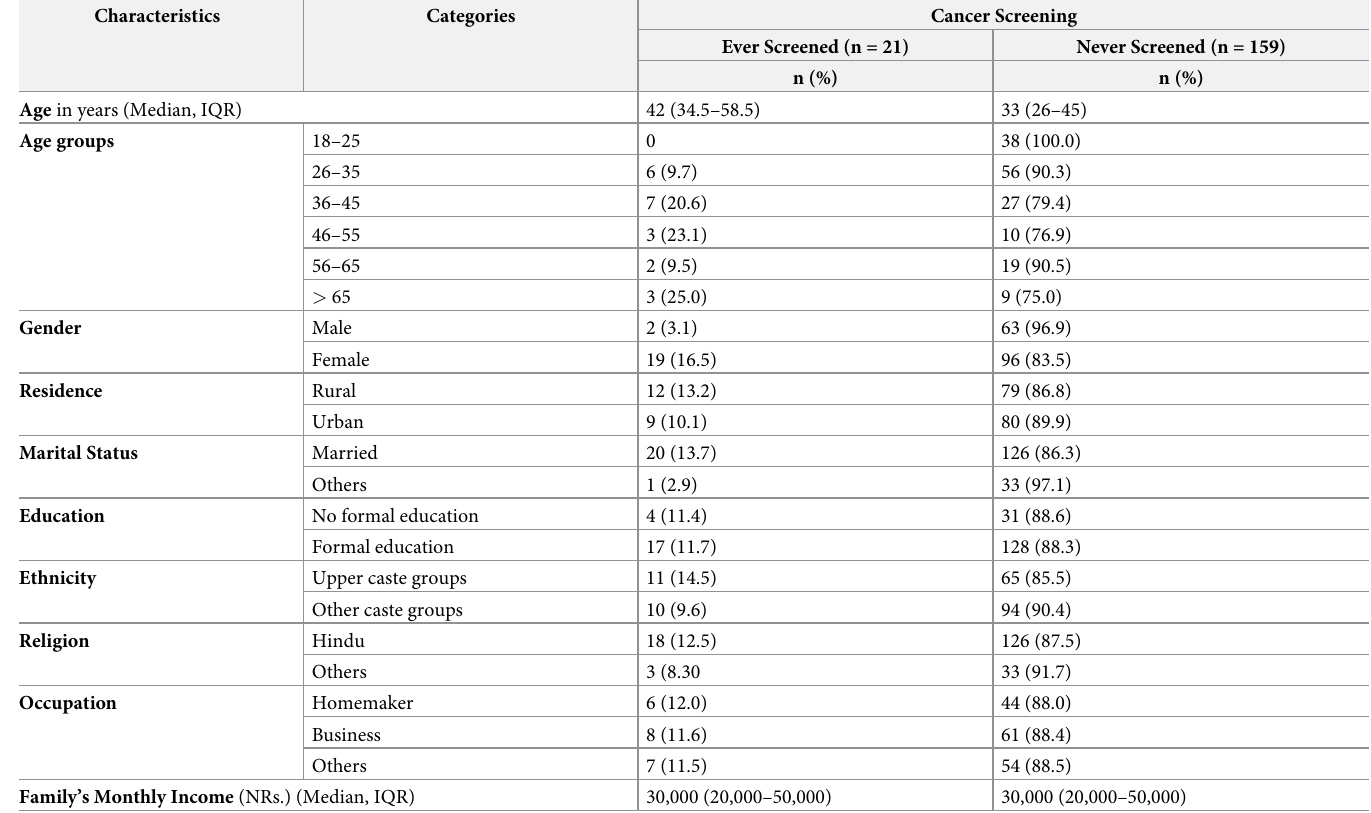
Table 1. Socio-demographic characteristics of the study participants (n = 180).